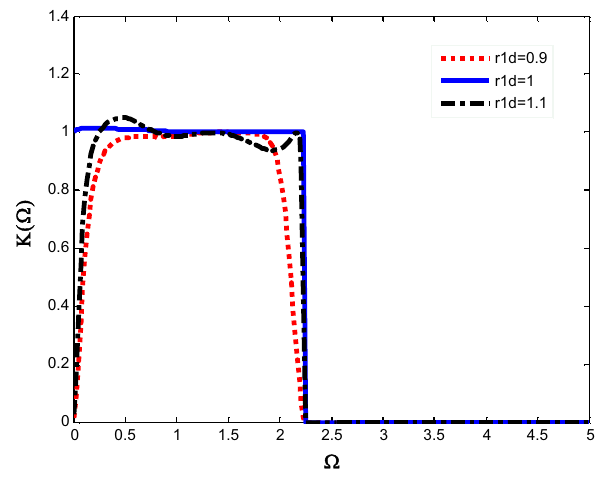
Figure 11: Phononic conductance or transmittance as function dimensionless Ω and elastic constant of the perturbed system.